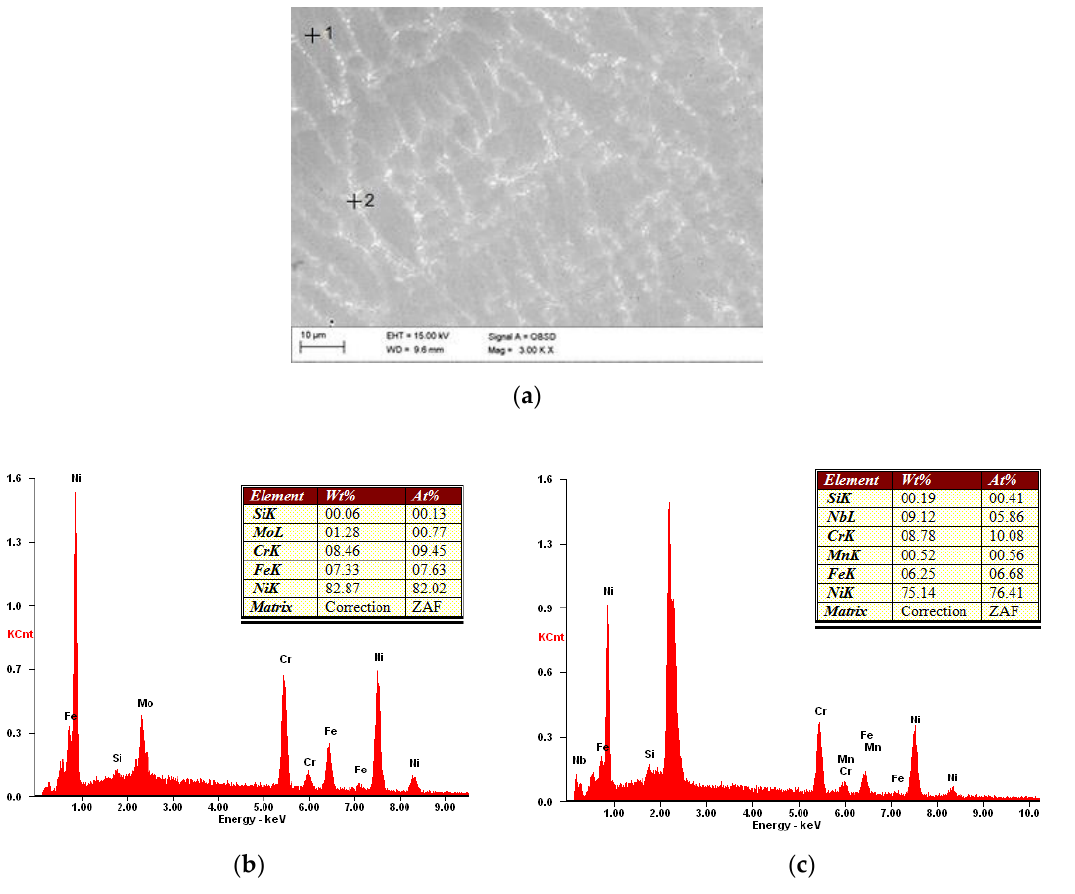
Figure 7. Sample BSE image of surfaced layer microstructure with results of EDS point microanalysis, mag. 3000 × , high tension 15 kV (sample L4): ( a ) a view of dendritic structure, ( b ) chemical analysis of intradendritic area (measurement point 1), ( c ) chemical analysis of interdendritic area (measurement point 2), higher content of Nb compared to Inconel 625 powder chemical composition is notable.